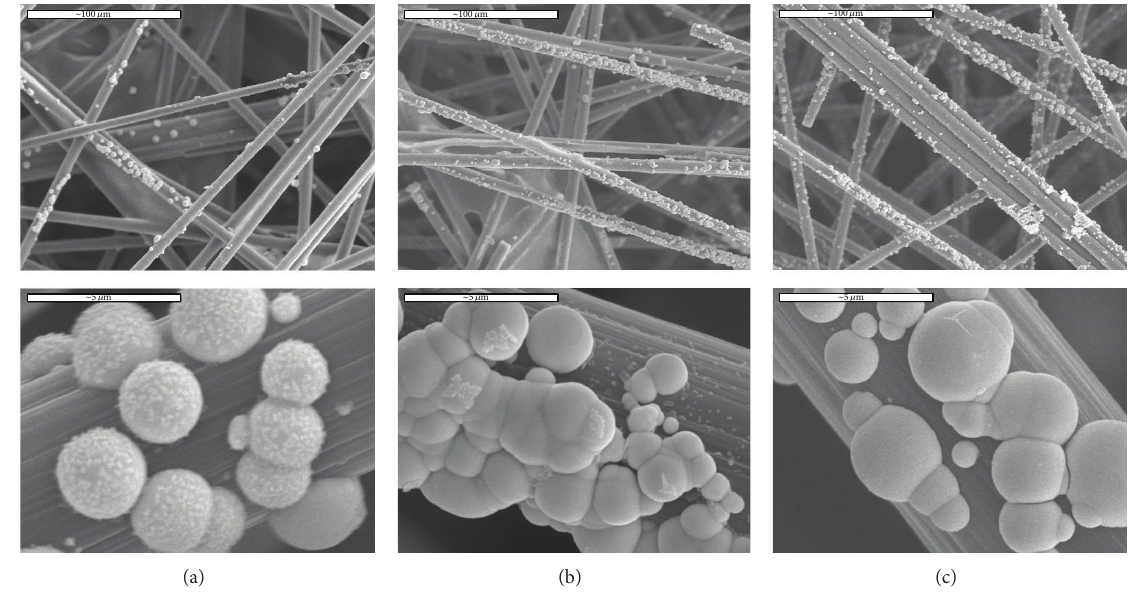
Figure 2: SEM images of the Pd-Au electrodeposits on carbon felt: (a) Pd 90 Au 10 ; (b) Pd 70 Au 30 ; (c) Pd 50 Au 50 .